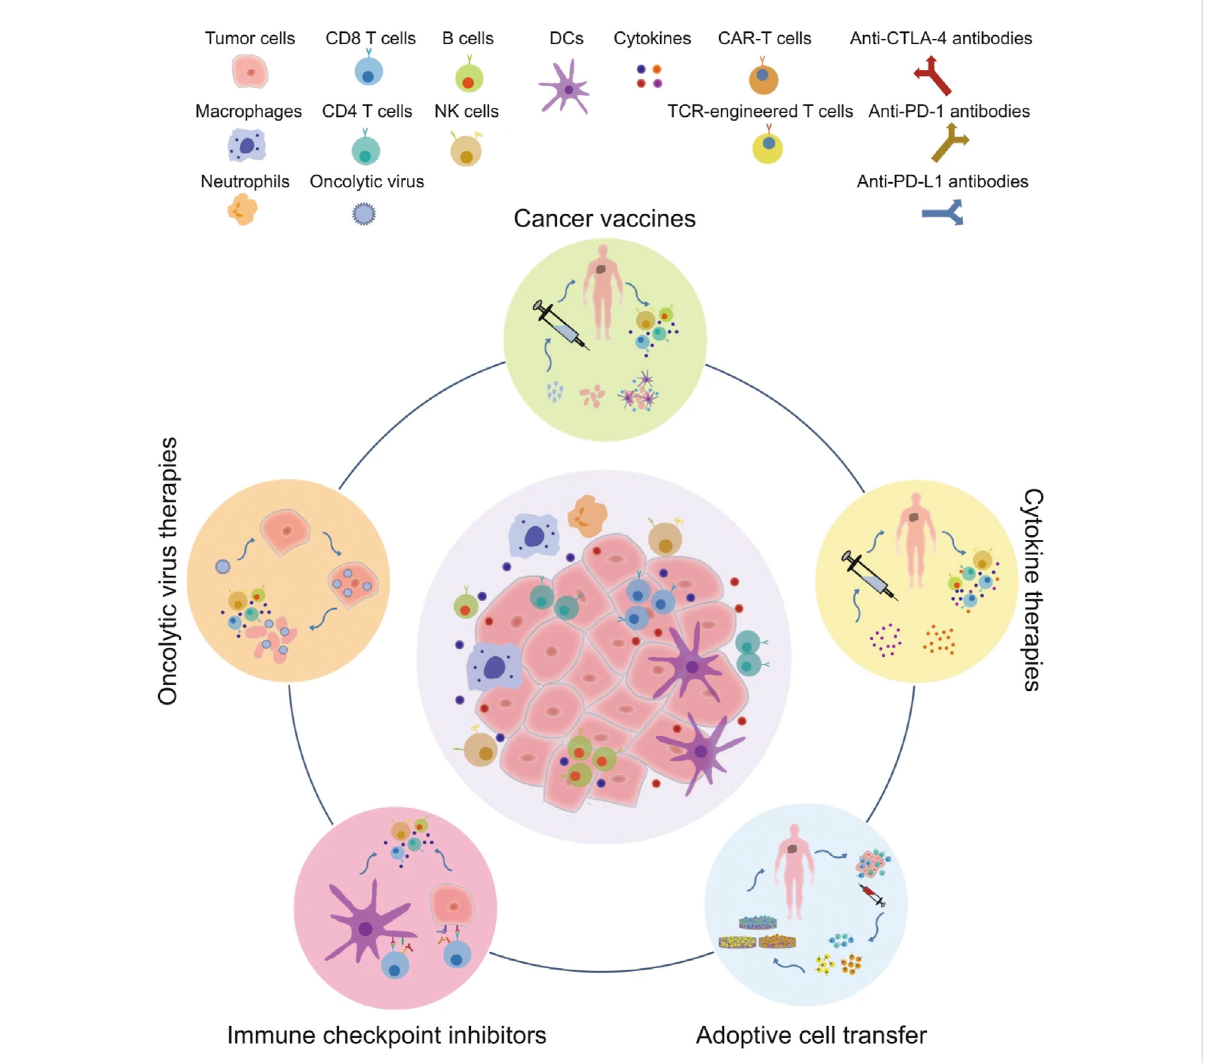
FIGURE 3 The major clinical categories of immunotherapy include oncolytic virus therapies, cancer vaccines, cytokine therapies, adoptive cell transfer, and immune checkpoint inhibitors (Zhang and Zhang,